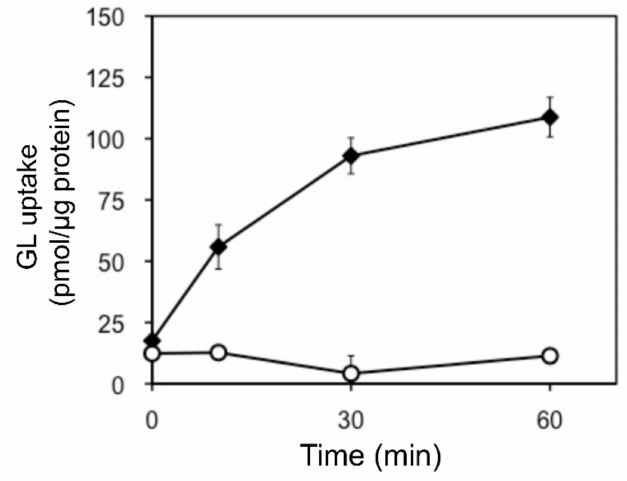
Figure 7. Time course of changes in GL uptake by tonoplast vesicles. Tonoplast vesicles (0–20% sucrose fraction) were incubated with GL (500 µ M) in the presence (filled diamond) or absence (circle) of 5 mM MgATP. Data are presented as the mean ± standard deviation from triplicate cultures.